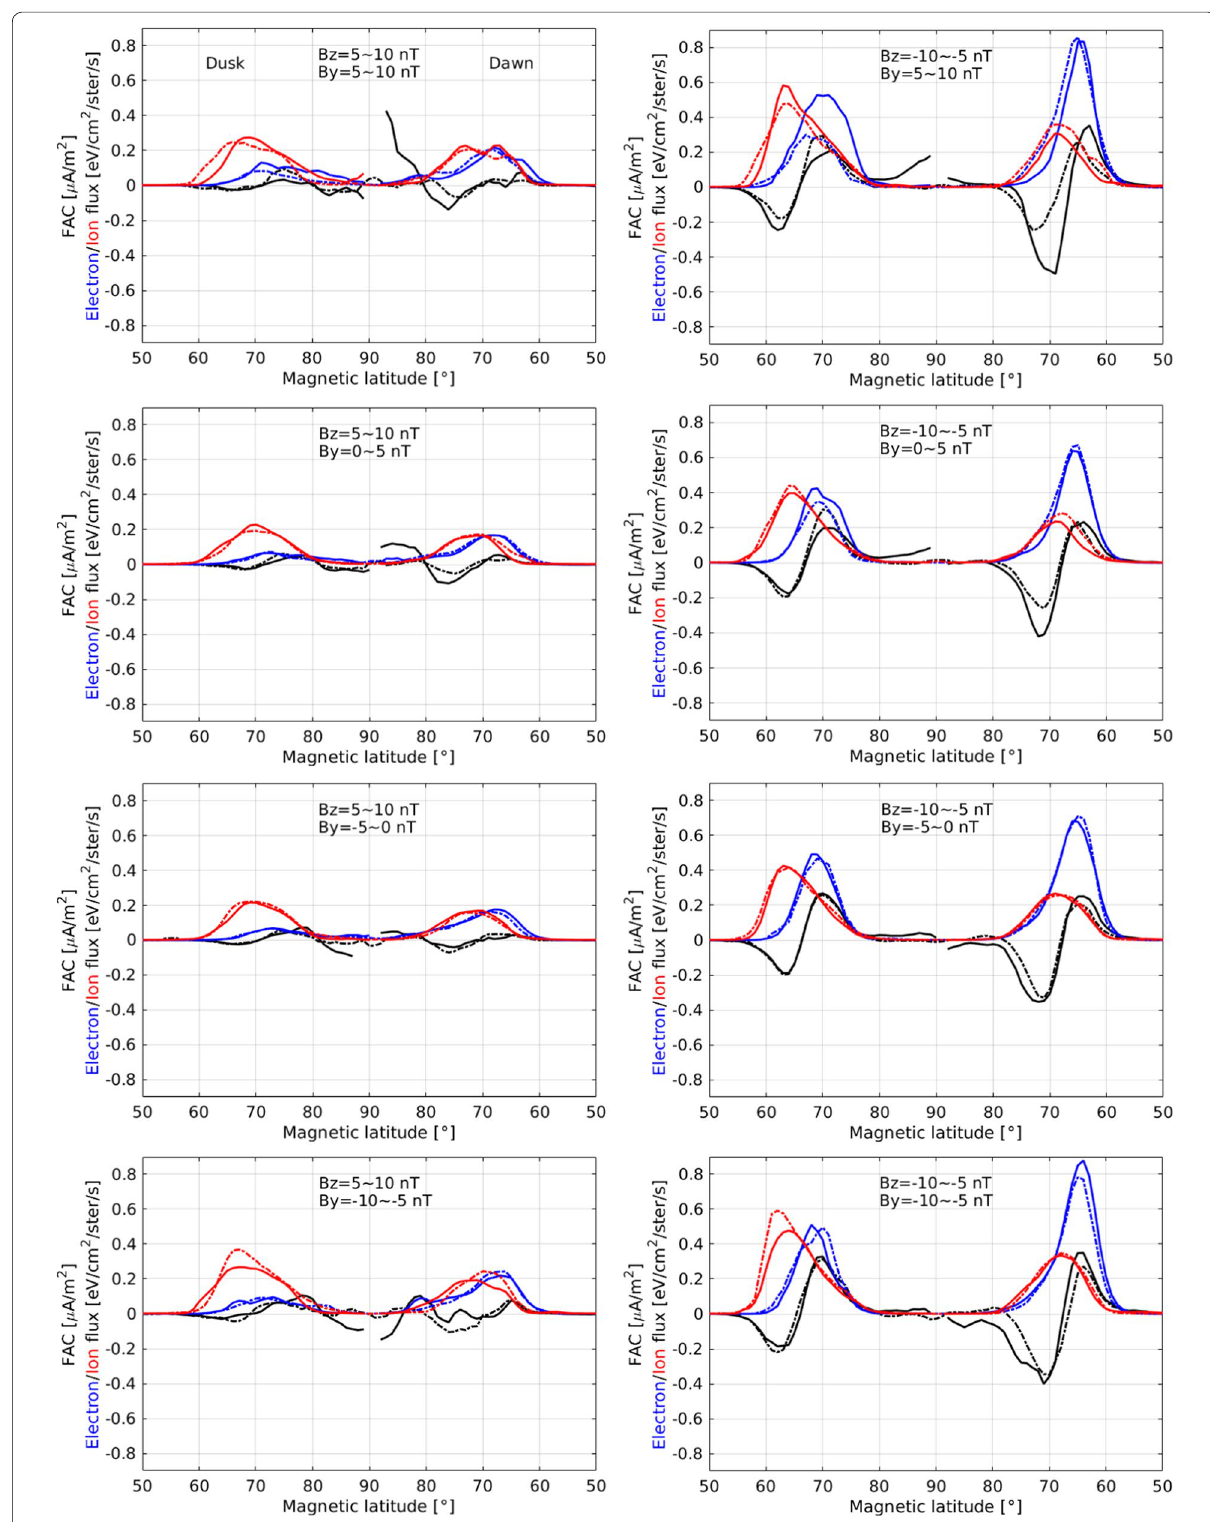
Fig. 7 The latitudinal profiles of FACs (black), energy flux of electron (blue) and ion (red), and quantities are averaged within on the dusk–dawn meridian. The solid and dashed lines represent the values in the northern and southern hemispheres, respectively. Here, we show only the results for the more northward (left, B z